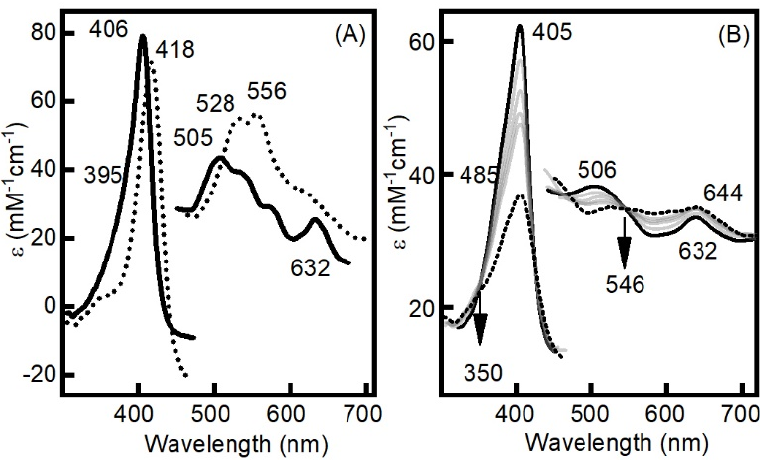
Figure 1. UV-vis spectra of ( A ) BsDyP, at open circuit potential (thick solid line) and at − 0.190 V potential (dashed line); ( B ) PpDyP at open circuit potential (thick solid line), changes within first two minutes at − 0.190 V potential (grey solid line) and final − 0.190 V product (dashed line). PpDyP, on the other hand, presents the Soret band at 405 nm with a shoulder at 385 nm, the Q-band at 506 nm and the charge transfer band at 632 nm (Figure 1B). The RR spectrum reveals three different populations regarding the heme axial coordination and spin: (i) a 6cHS fraction with bands at 1368 ( ν 4 ), 1488 ( ν 3 ), 1518 ( ν 38 ) 1557 ( ν 19 ) cm − 1 ; (ii) a 5cHs form with bands at 1371 ( ν 4 ), 1495 ( ν 3 ), 1567 ( ν 2 ) and 1581 ( ν 37 ) cm − 1 ; and (iii) a five-coordinated quantum mechanically mixed-spin (5cQS) population, characterized by bands at 1374 ( ν 4 ), 1503 ( ν 3 ) and 1525 ( ν 38 ) cm − 1 (Figure 3A). This latter spin species